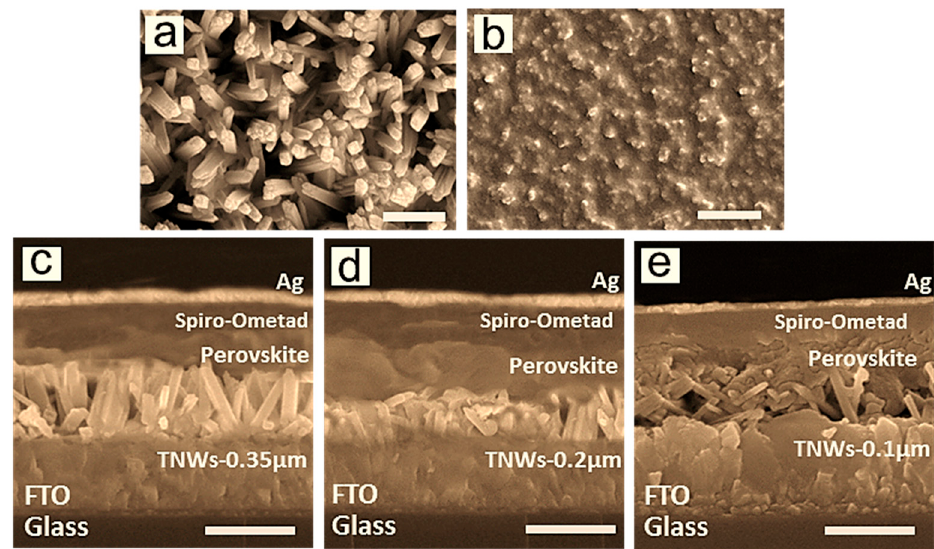
Figure 2. ( a ) Top rough surface of the TNWs and, ( b ) conformal CH 3 NH 3 PbI 3 coated TNWs, ( c – e ) Cross-sectional FESEM images of solid-state TNWs/Perovskite solar cells with compact TNWs lengths of 0.35 µm, 0.2 µm, and 0.1 µm. All figures have scale bar of 0.5 µm.